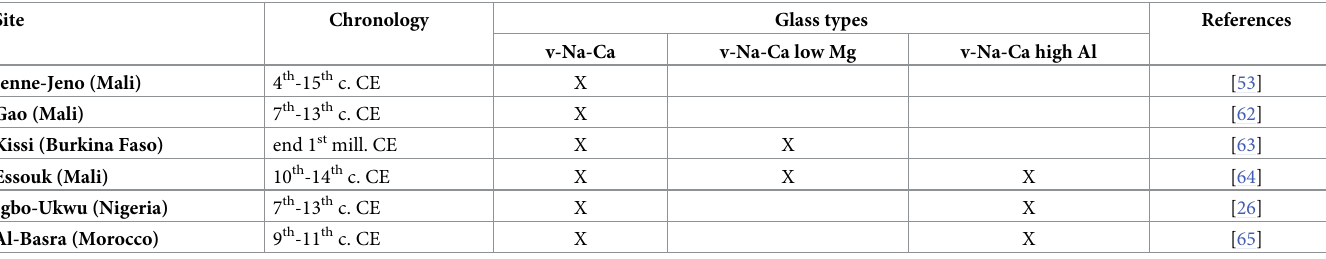
Table 4. West African glass bead assemblages considered for